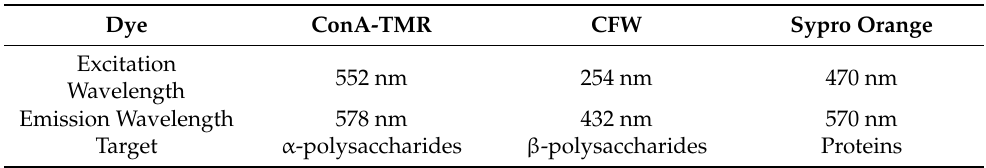
Table 1. The wavelengths of the emission and excitation of the fluorescent dye compared to the components of the biofilm